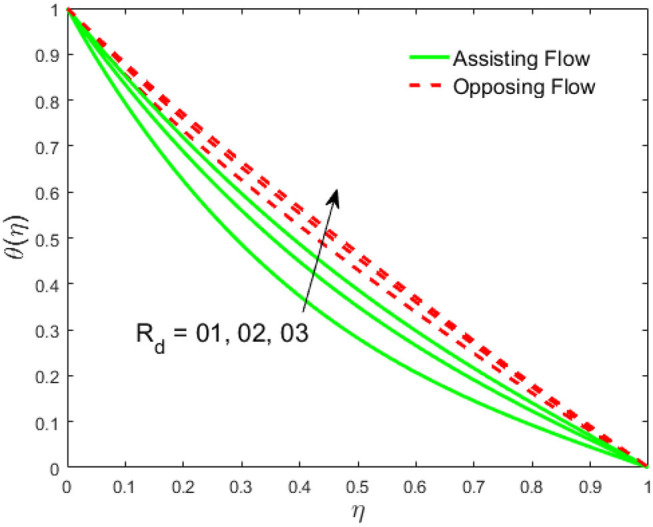
Impact of Rd on θ(η).